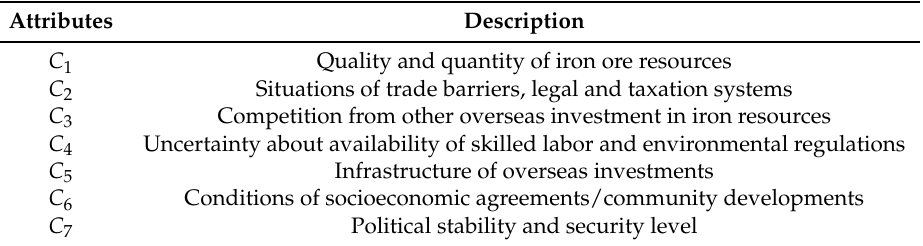
Table 5. Description of the seven